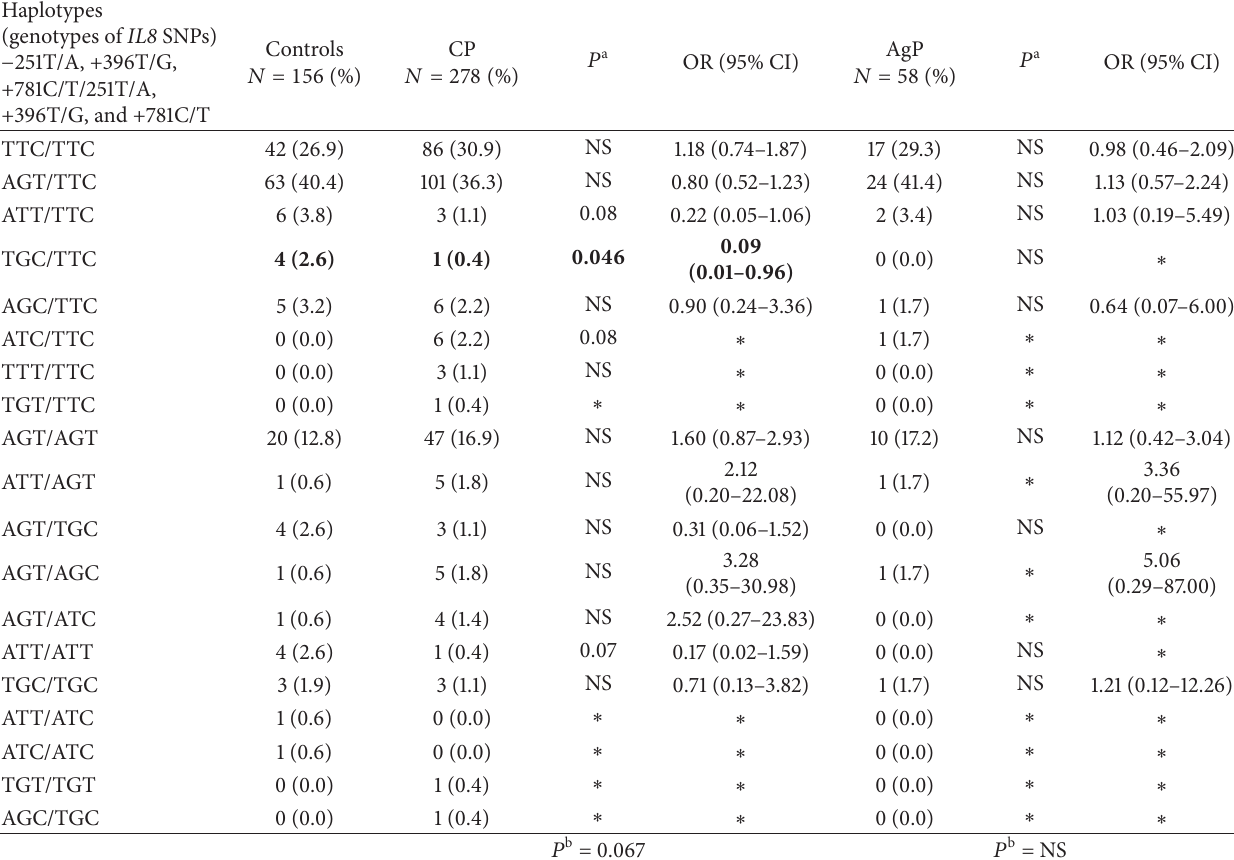
Table 4: Distribution of IL8 haplotypes (arranged as genotypes) in the studied groups.